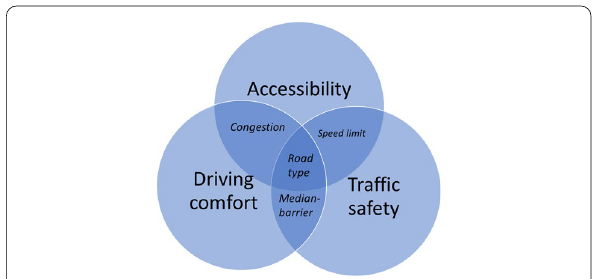
Fig. 1 Illustration of relationship between driving